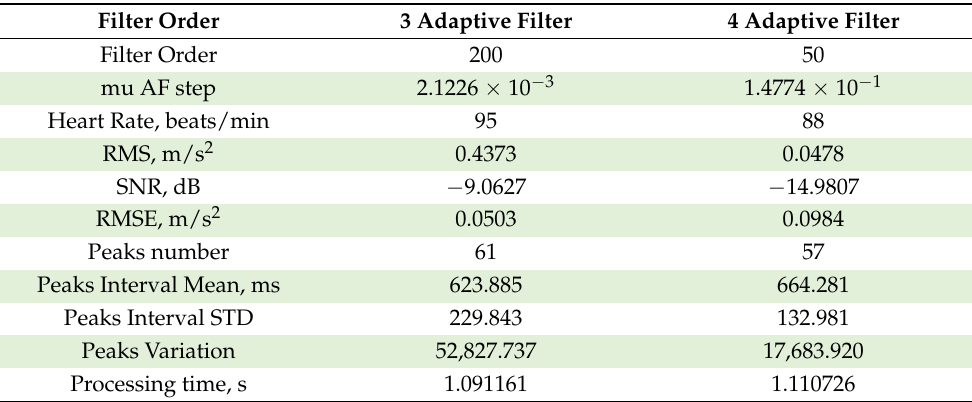
Table 6. Rest SCG signal processing data with individually adjusted adaptive filters.